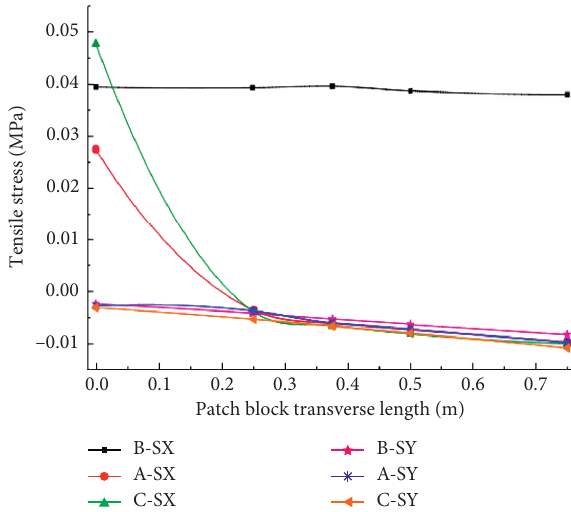
Figure 4: The effects of lateral movement of different loading positions on tensile stress of patch block.